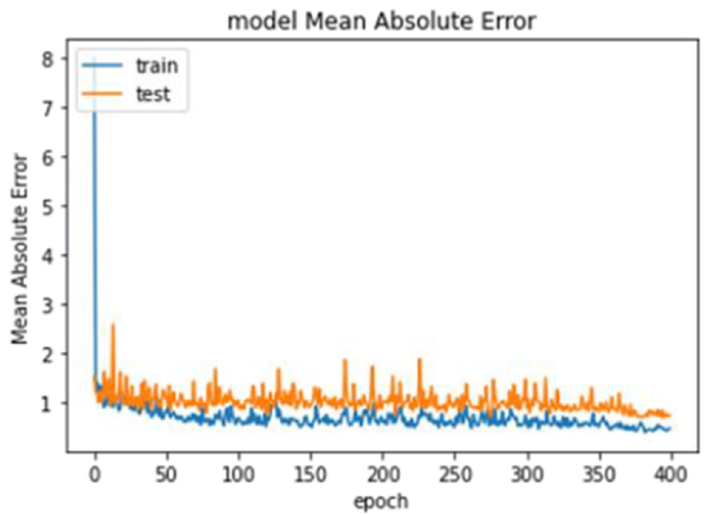
Figure 7. Error rate for Experiment 3 through epochs. Experiment 4 only tested the images for age seven. The dataset consisted of 85 images, 68 images for training and 17 images for testing. The VGG16 model produced the lowest error rate (0.6915). Figure 8 shows the error rate of VGG16 through the epochs.